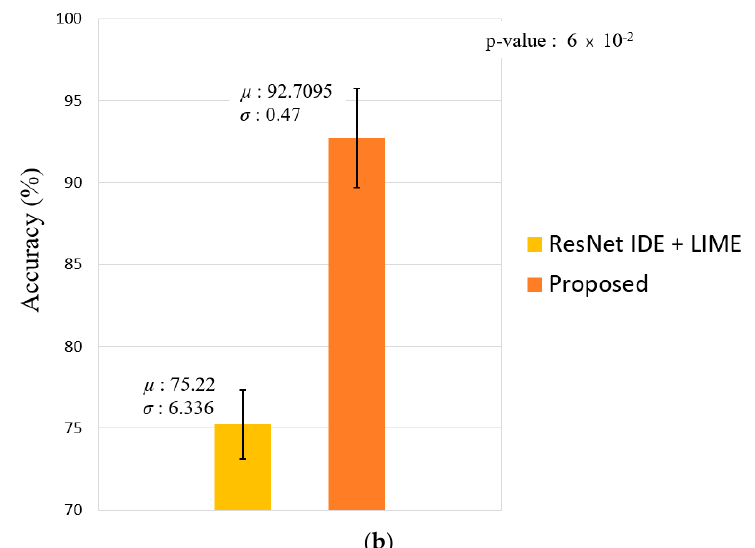
Figure 12. Graphs for t-test result between the second best model and our proposed method with respect to accuracy of average recognition. ( a ) Comparison between ResNet-50 and the proposed method, and ( b ) comparison between ResNet IDE + LIME and the proposed method.